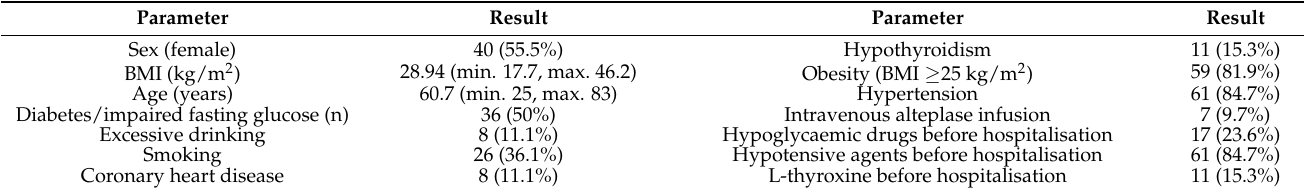
Table 1. Characteristics of the study group ( n =